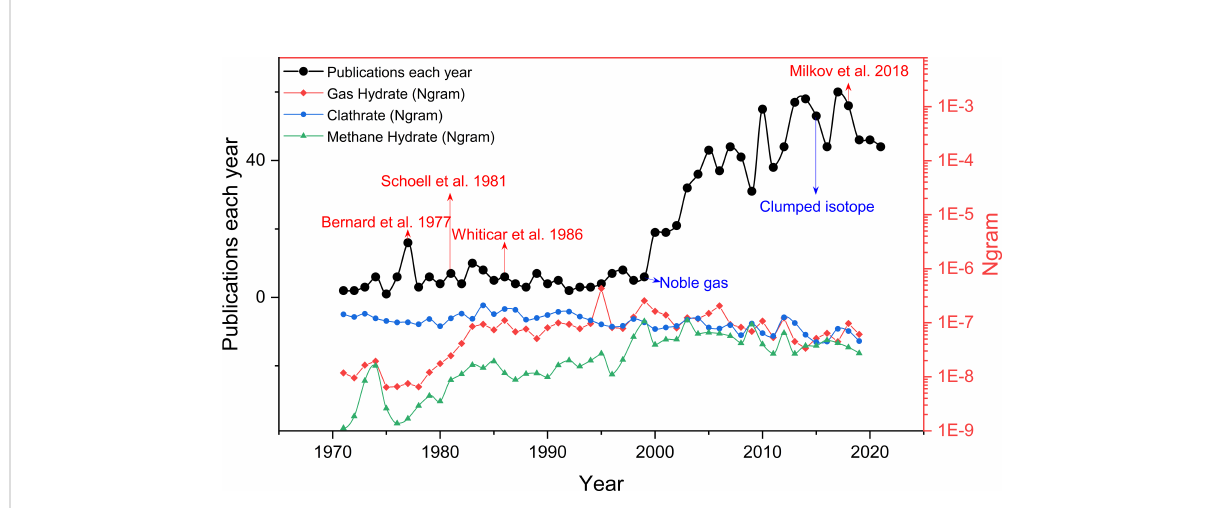
FIGURE 1 The line of black solid dot represents the number of research articles about gas geochemistry (molecular and/or isotopic composition data) of natural gas hydrate published each year from 1970 to 2021 (data from web of science), modi fi ed from Milkov and Etiope (2018). Note that data for about 87% of all samples were published after the genetic diagrams of Bernard et al. (1977); Schoell (1983); Whiticar et al. (1986) and Milkov and Etiope (2018)were proposed. Three line of colored dot represents how those phrases (gas hydrate, clathrate and methane hydrate) have occurred in a corpus of books over the selected years (1970-2019) (data from Google N-gram viewer, (Michel et al., 2011)). We can see that use of “ gas hydrate ” and “ methane hydrate ” started to rise in 1980s, match to the publication of the genetic diagrams, while the frequency of the term "clathrate" declined steadily from the